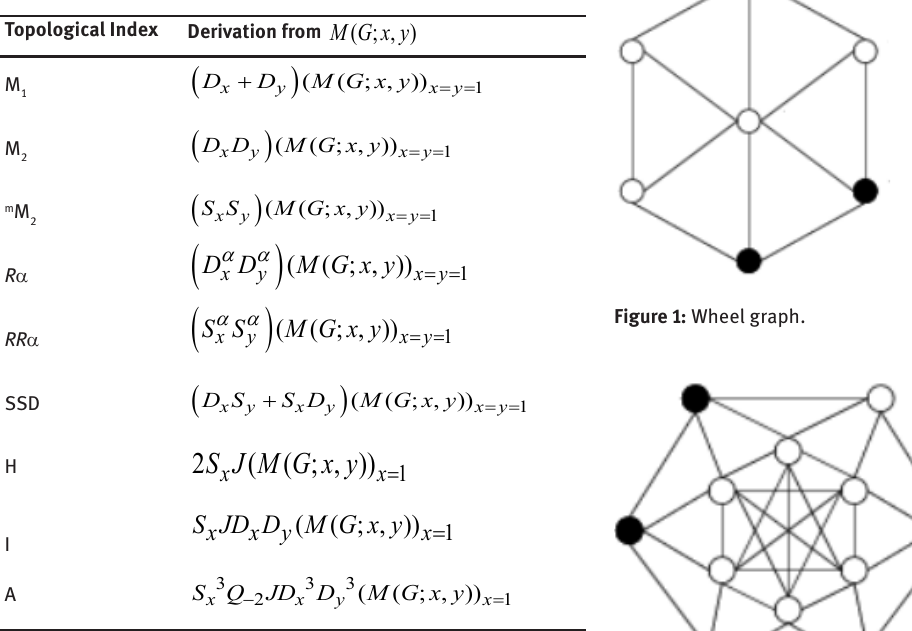
Figure 1: Wheel graph.